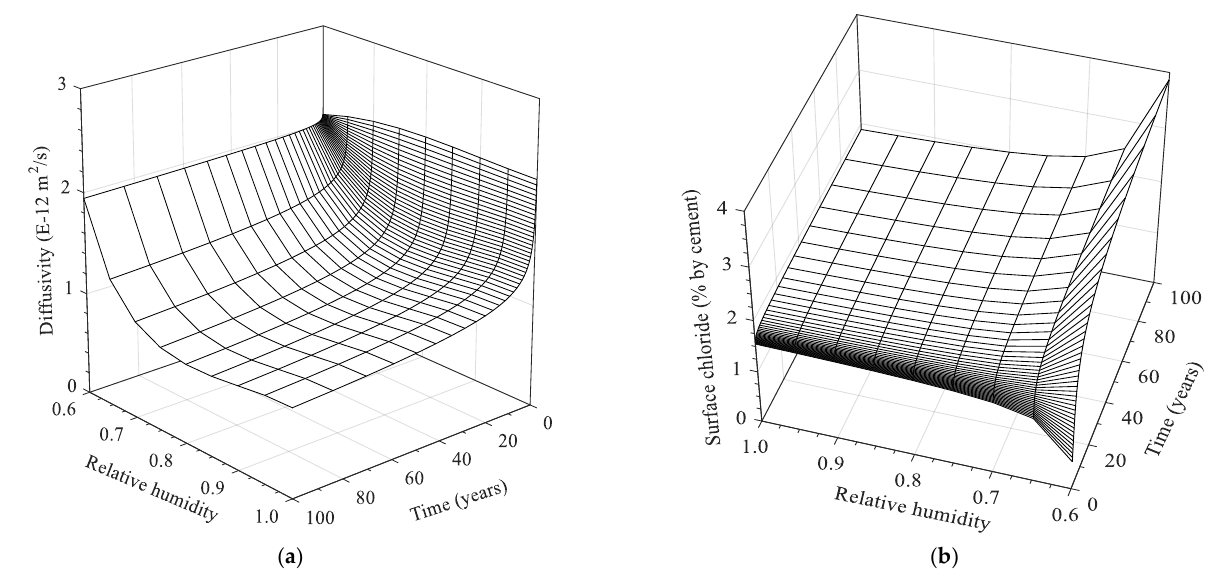
Figure 6. Change in parametric values dependent on relative humidity and time for ( a ) apparent diffusion coefficient and ( b ) surface chloride content.